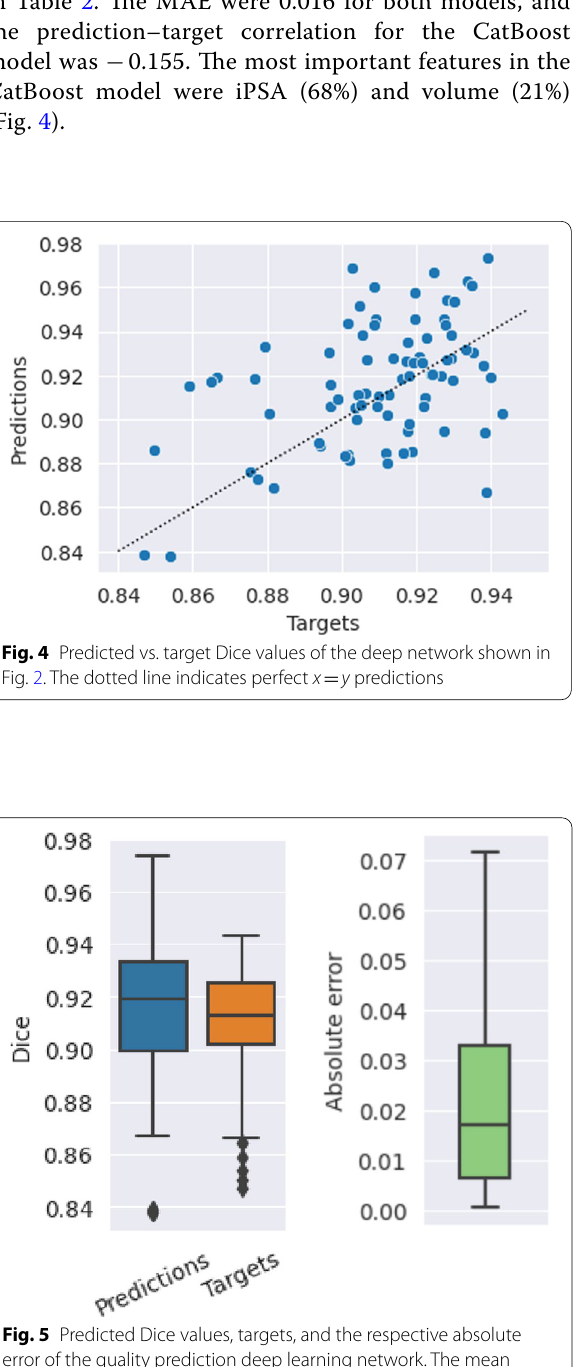
Fig. 5 Predicted Dice values, targets, and the respective absolute error of the quality prediction deep learning network. The mean absolute error is 0.02 and the correlation between the predicted and target values are